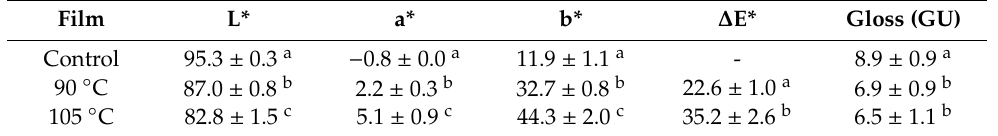
Table 2. Colour and gloss values of control and thermally treated films.